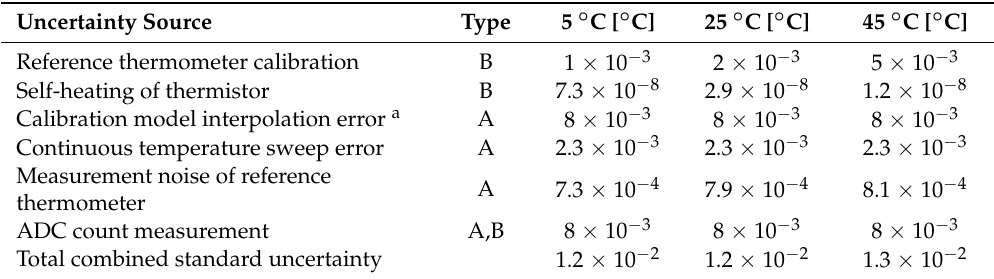
Table 5. Uncertainty budgets for the calibration